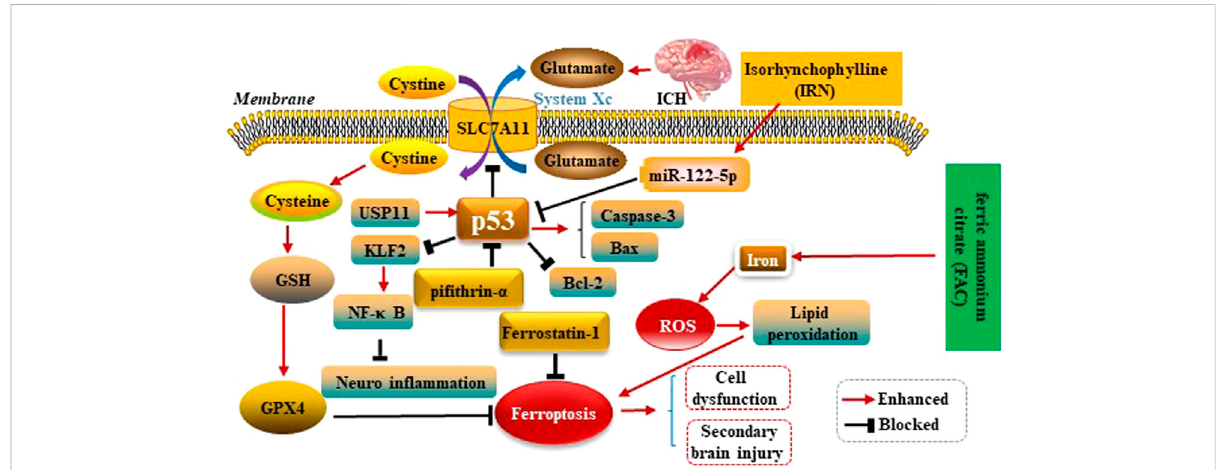
FIGURE 5 p53 modulates ferroptosis in ICH. p53 inhibits SLC7A11 resulting in dysfunction of the cystine/glutamate antiporter (System Xc − ) after ICH, leading to decreased synthesis of glutathione (GSH) and activity of glutathione peroxidase 4 (GPX4). p53 could increase Caspase-3 as well as Bax expressions, and decrease Bcl-2 expression conversely. Therefore, P53 plays key roles in SBI caused by ICH. IRN suppressed the p53 expression to anti-ferroptosis via miR-122 – 5p/p53/SLC7A11 pathway. Ubiquitin-speci fi c protease 11(USP11) stabilized p53 by deubiquitination